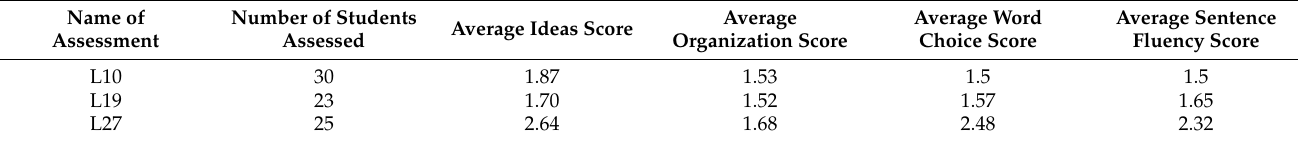
Table 4. Results as Measured by Writing